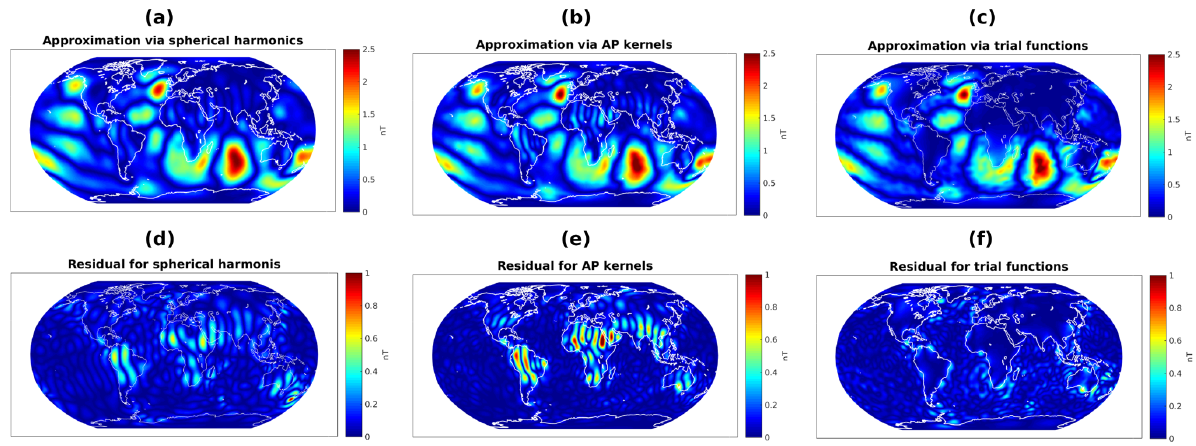
Figure 9. Absolute value of the radial part of approximations of superposition B e oc based on dictionary D 1 (a) , dictionary D 2 (b) , and dictionary D 3 (c) , as well as the corresponding residuals with respect to original B X3DG oc without the continental “noise” e (d, e, f) .